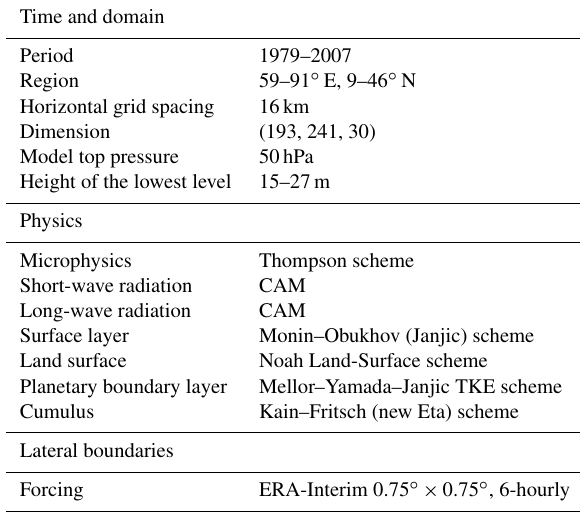
Table 2. The main settings of the WRF regional climate model. The complete setting are shown in the